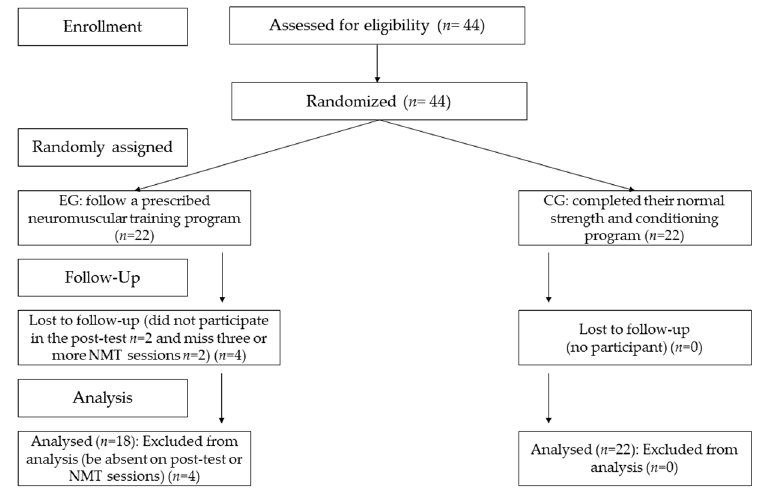
Figure 1. Participant recruitment, allocation, follow-up, and analysis are depicted in a CONSORT diagram. NMT: neuromuscular training; EG: experimental group; CG: control group. Table 2. Average macronutrient and energy